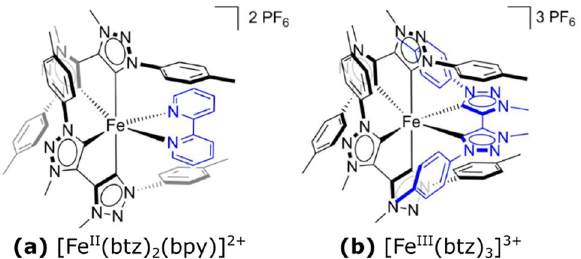
Figure 1. Schemes of the two Fe-NHC complexes studied: (a) [ Fe II ( btz ) 2 ( bpy ) ] 2 + and (b) [ Fe III ( btz ) 3 ] 3 + , where btz = 3,3’-dimethyl-1,1’-bis(p-tolyl)-4,4’-bis(1,2,3-triazol-5-ylidene) and bpy = 2,2’-bipyridine.